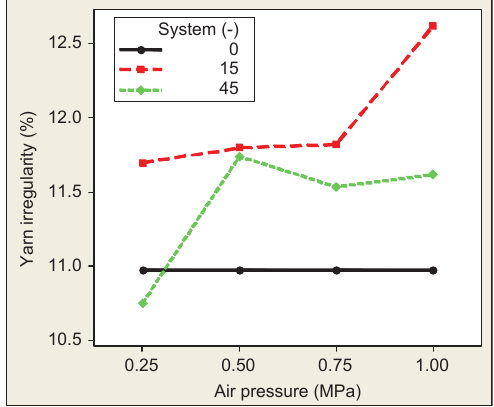
Figure 14 Yarn irregularity